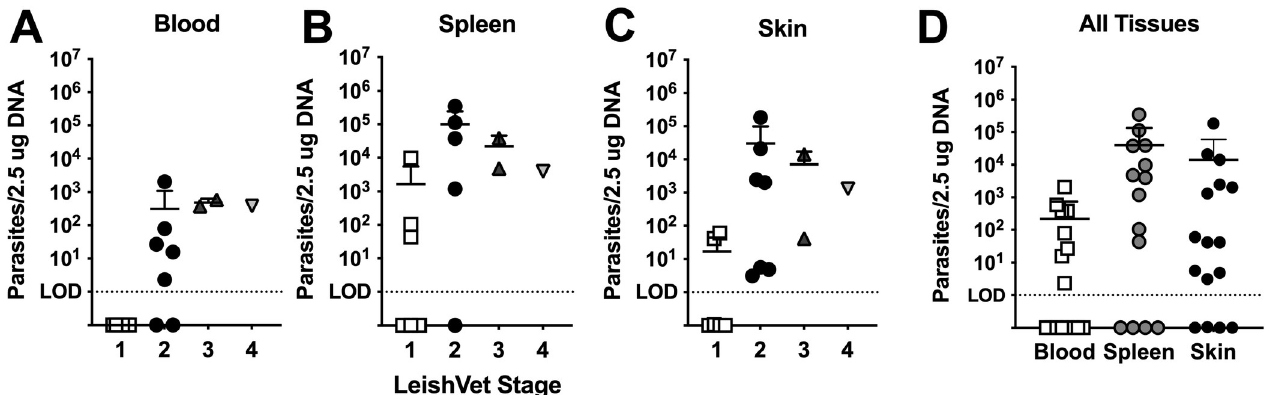
Fig 1. Vertically infected dogs harbor significant skin Leishmania burden. Calculated L . infantum parasite burden in (A) blood (n = 16), (B) spleen (n = 14), (C) skin (n = 16) from dogs at indicated LeishVet clinical stage of disease. (D) Calculated L . infantum parasite burden in all tissues from all dogs independent of LeishVet status. Each symbol represents one dog. For skin, the average burden of all sampled skin sites per dog is shown.